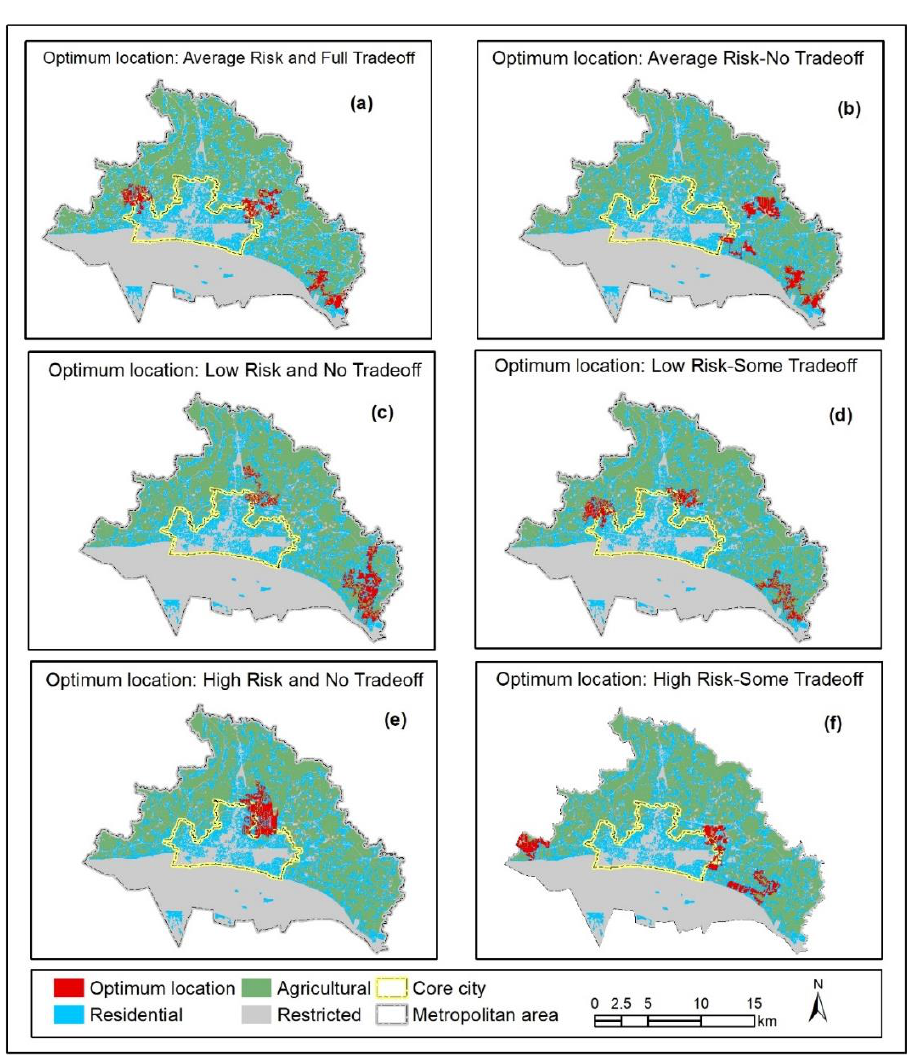
Figure 8. Optimum location of new residential development under different decision strategies: ( a ) average risk and full trade-off; ( b ) average risk and no trade-off; ( c ) low risk and no trade-off; ( d ) low risk and some trade-off; ( e ) high risk and no trade-off; ( f ) high risk and some trade-off. Figure 8. The optimum locations of new residential development are